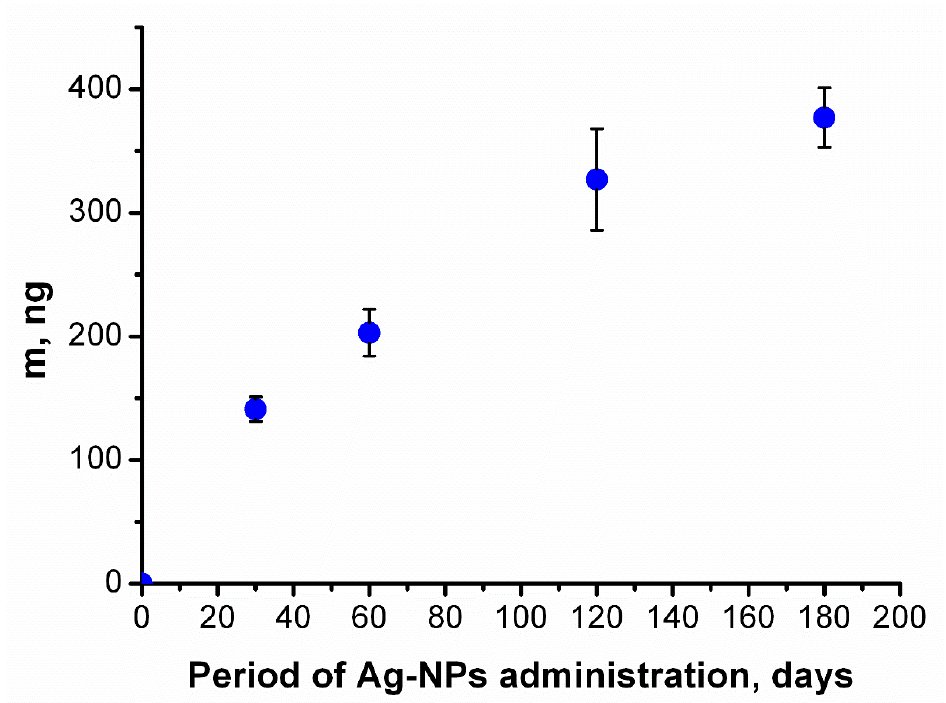
Figure 3. Accumulation of silver in the brain. Dependence of the mass of silver in the brain on the period of administration of Ag-NPs obtained by NAA. Silver monotonically accumulated in the brain over time. Data are represented as the mean ± SEM.